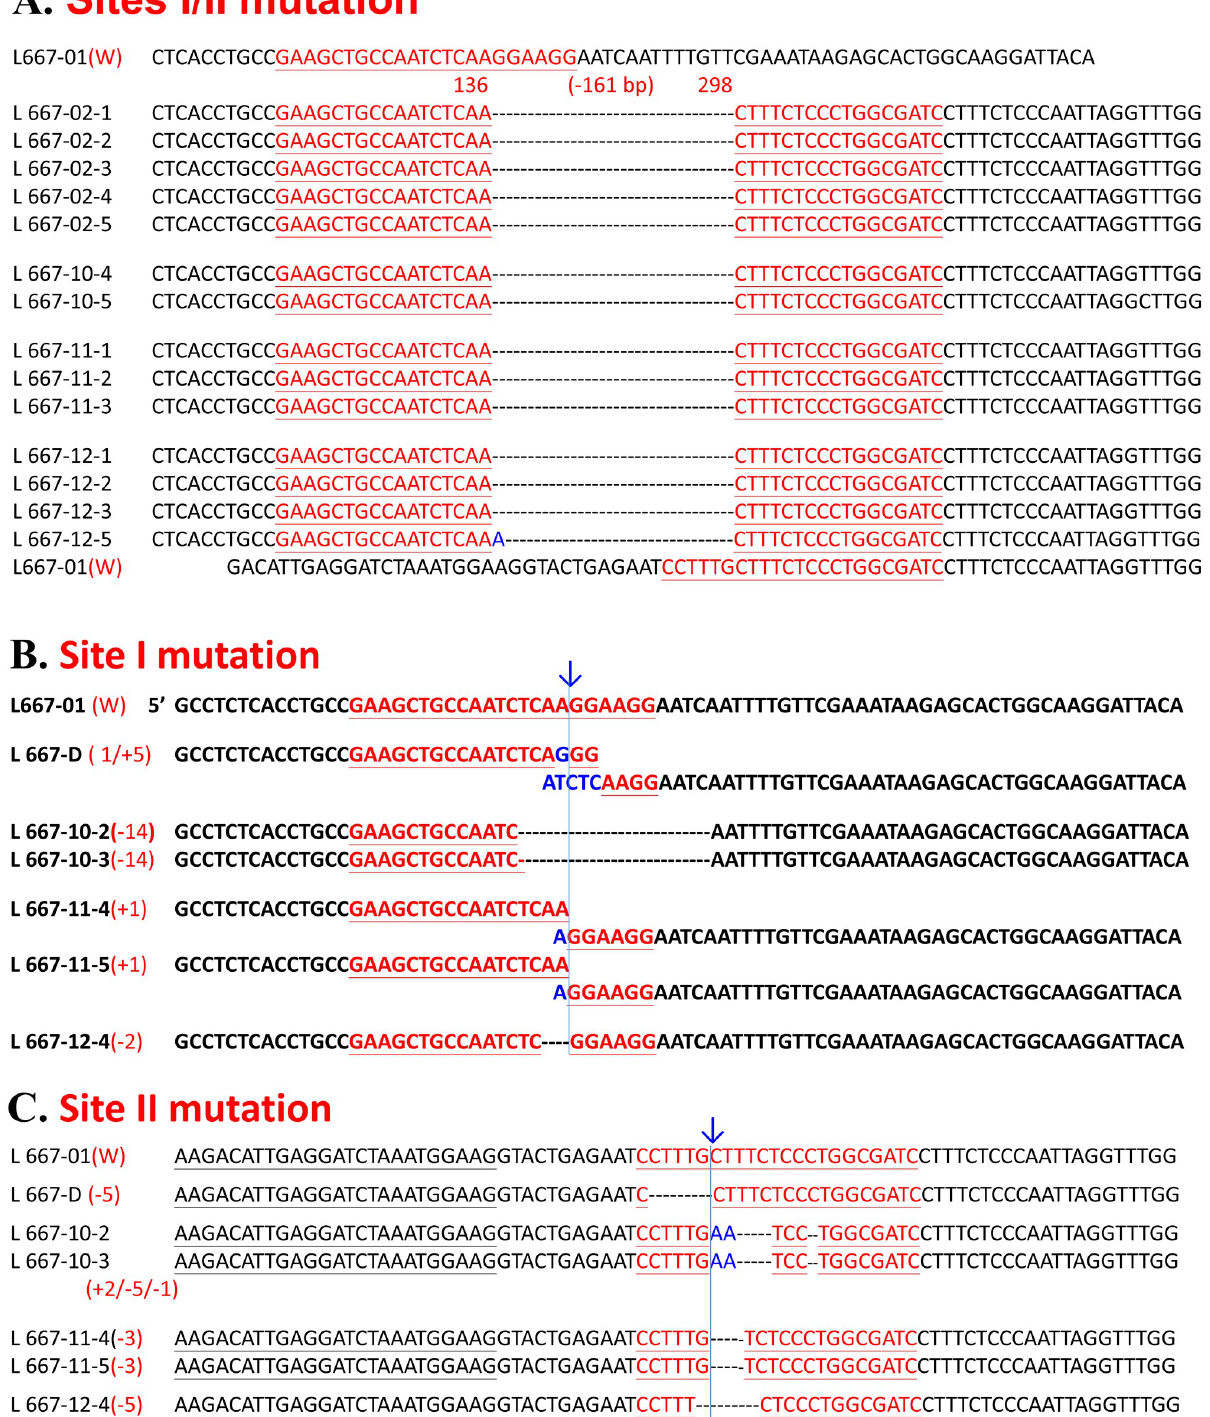
Fig 4. Genotyping by TA-cloning and sequencing of the porcine CMAH gene edited by CRISPR/Cas9 vectors directed against two sites. A. The genotype shown displays two simultaneously mutated sites and a deleted 161-bp DNA fragment; the blue A represents an extra inserted base that appeared in L667-12. B. The indel occurred at site I of exon II of the CMAH gene. C. Details of the mutation at site II of intron 2 of the CMAH gene. The blue arrows and lines indicate the cutting site of Cas9. The blue letters represent inserted bases, and the dashed line indicates deleted bases.